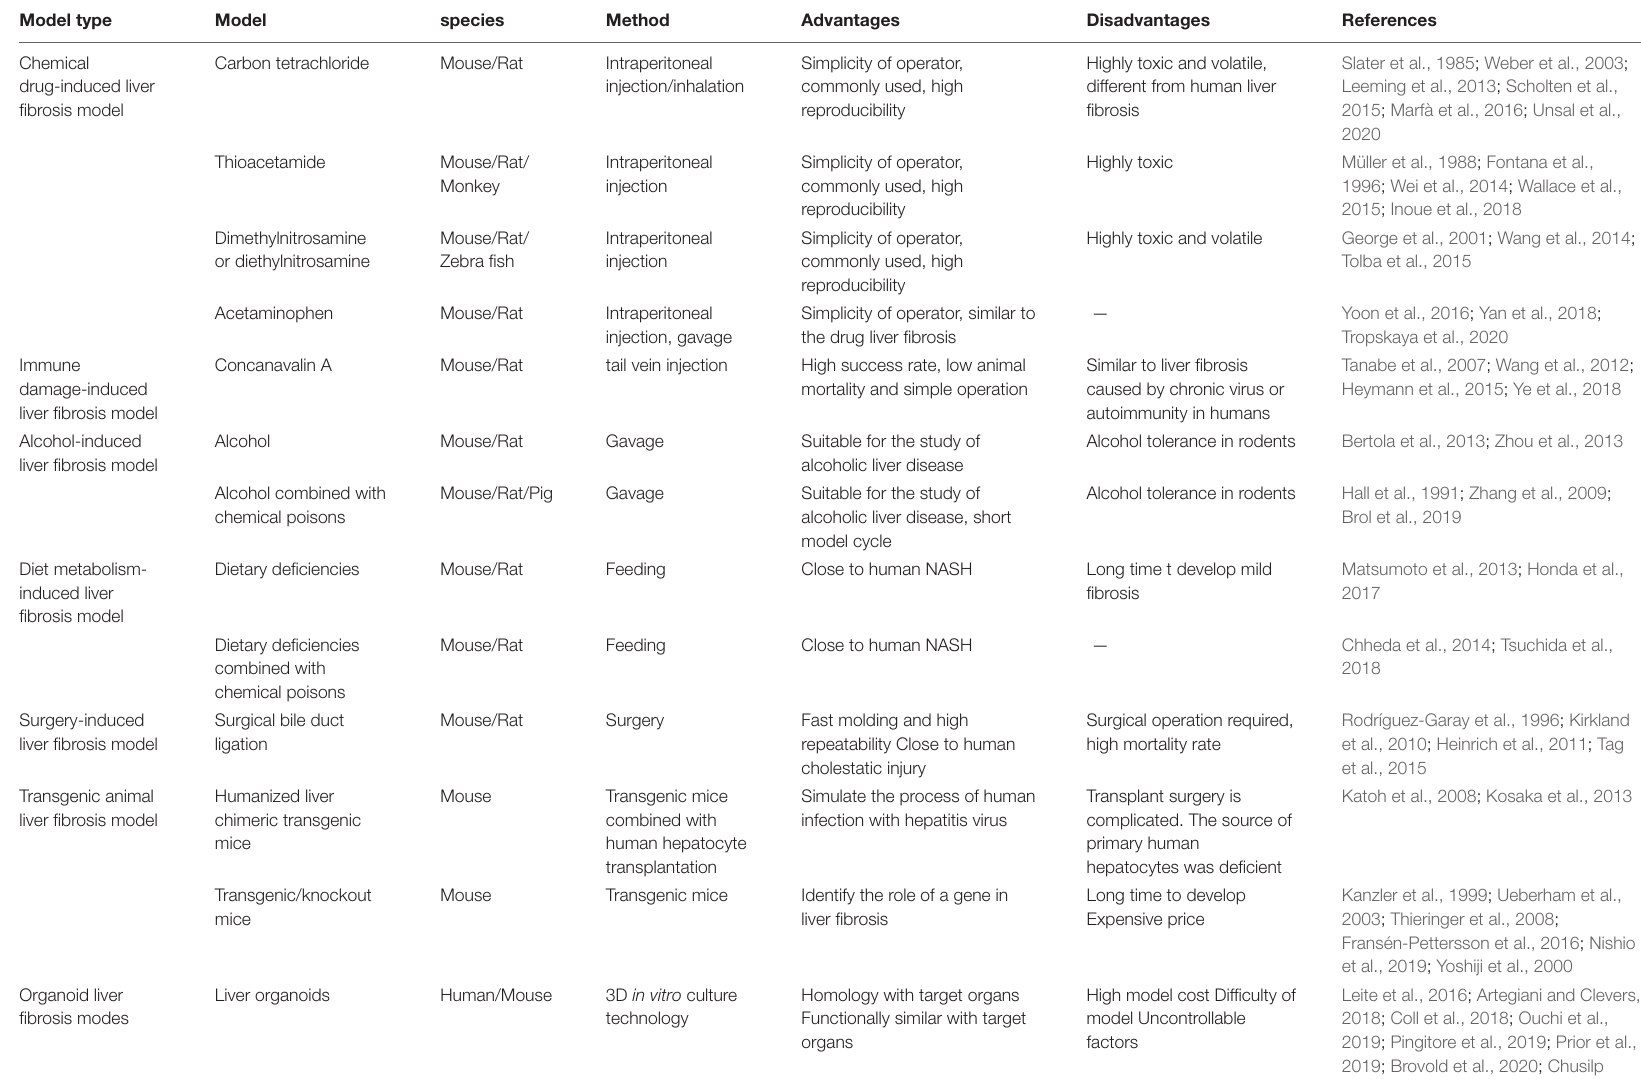
TABLE 1 | Advantages and disadvantages of different methods in hepatic fibrosis